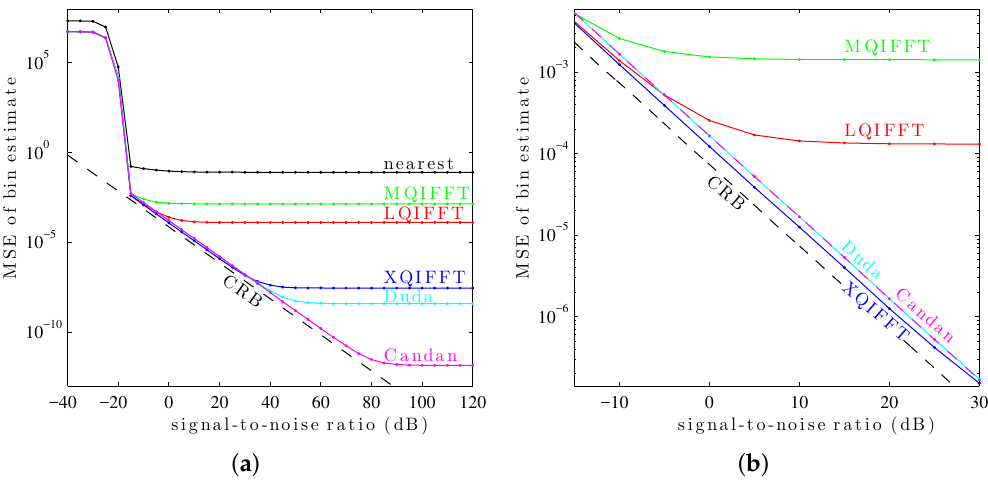
Figure 9. MSE of bin error as a function of singal-to-noise ratio. ( a ) Full SNR range; ( b )